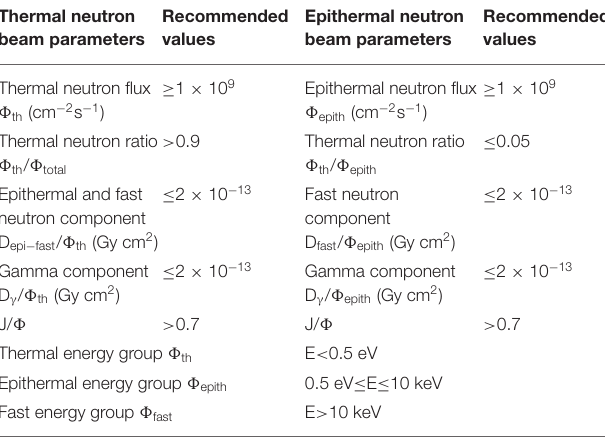
TABLE 1 | Neutron beam parameters and IAEA recommended values. Thermal neutron Recommended Epithermal neutron beam parameters values beam parameters